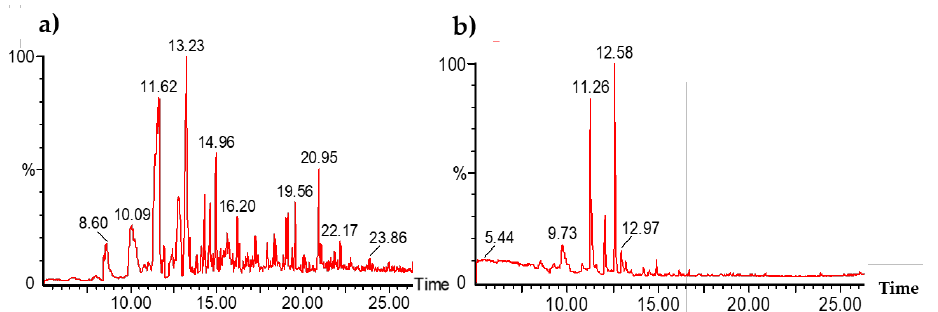
Figure 3. TIC (Total Ion Chromatogram) of quantified compounds in wood tar wastewater with internal standards from SPA sampling (Y-axis: Relative intensity). Tar species and content ratios in syngas: after passing through ( a ) water scrubber column and ( b ) Mg/Al-LDH@clinoptilolite.